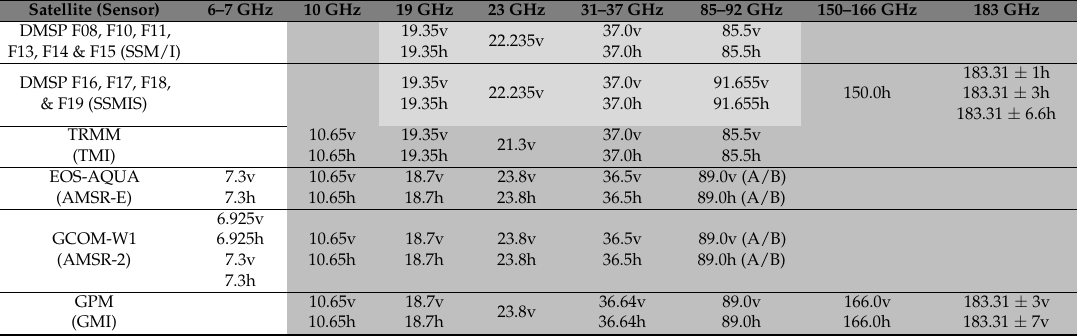
Table 1. Frequency and polarization (v = vertical, h = horizontal) of channels for radiometers in the FCDR datasets. The light gray shading indicates sensors/channels in the original SSMI(S) FCDR. The dark gray shading indicates the additional intercalibrated channels included in the Level 1C dataset. The 6.9 and 7.3 GHz channels on AMSR-E and AMSR2 are not included in the Level 1C